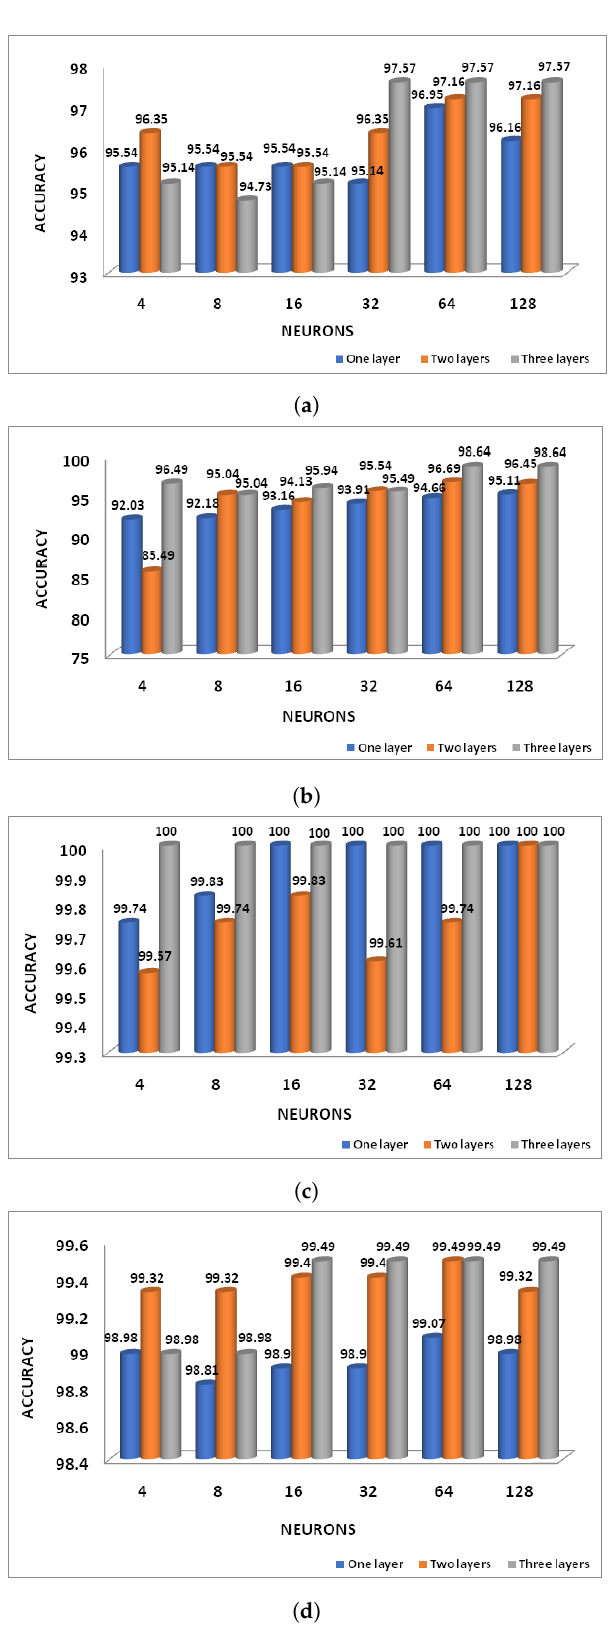
Figure 12. Testing performance of DNN model on variety of data. ( a ) Noise level: 10 to 50 (Dataset-1). ( b ) THD level: 10 to 50 (Dataset-2). ( c ) THD level: 50, noise level: 10 to 40 (Dataset-3). ( d ) Noise level: 5 to 20